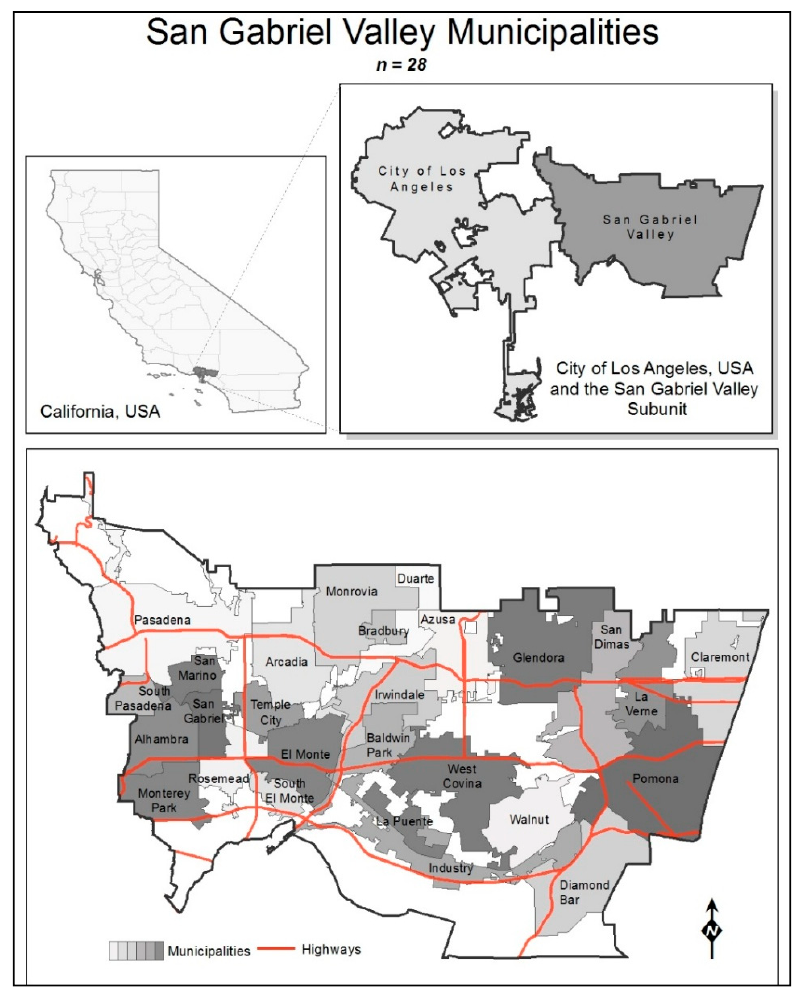
Figure 1. The Los Angeles Region Subset. These cities are located in Los Angeles County and include the City of Los Angeles plus 27 cities in the San Gabriel Valley. Source: [85].